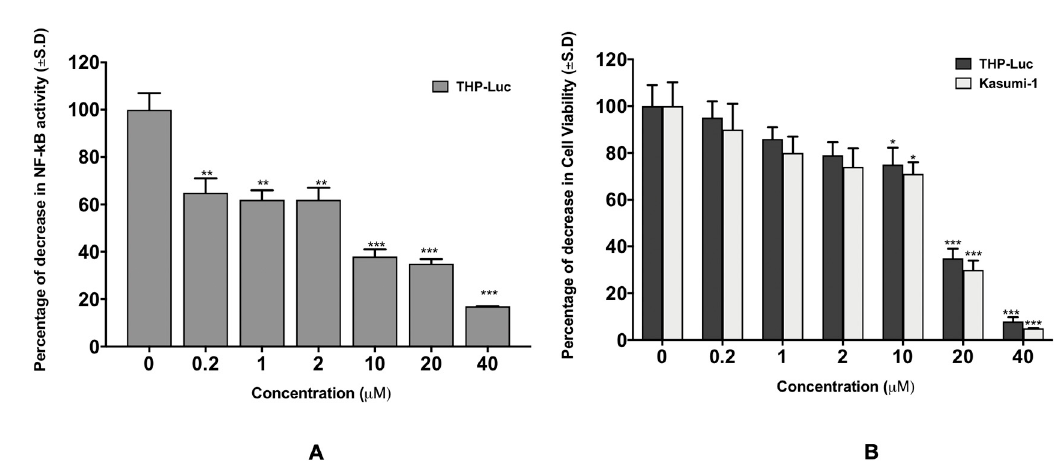
Figure 1. P-bi-TAT effect on leukemic cell lines. (A) THP1-lucia NF-kB activity (luciferase assay) after 48-h treatment, ( B ) THP1-lucia and Kasumi-1 cell vitality (MTT assay) after 48-h treatment. Results are expressed as mean ± S.D, n = 3. (*** p < 0.0001, ** p < 0.001, * p < 0.01).